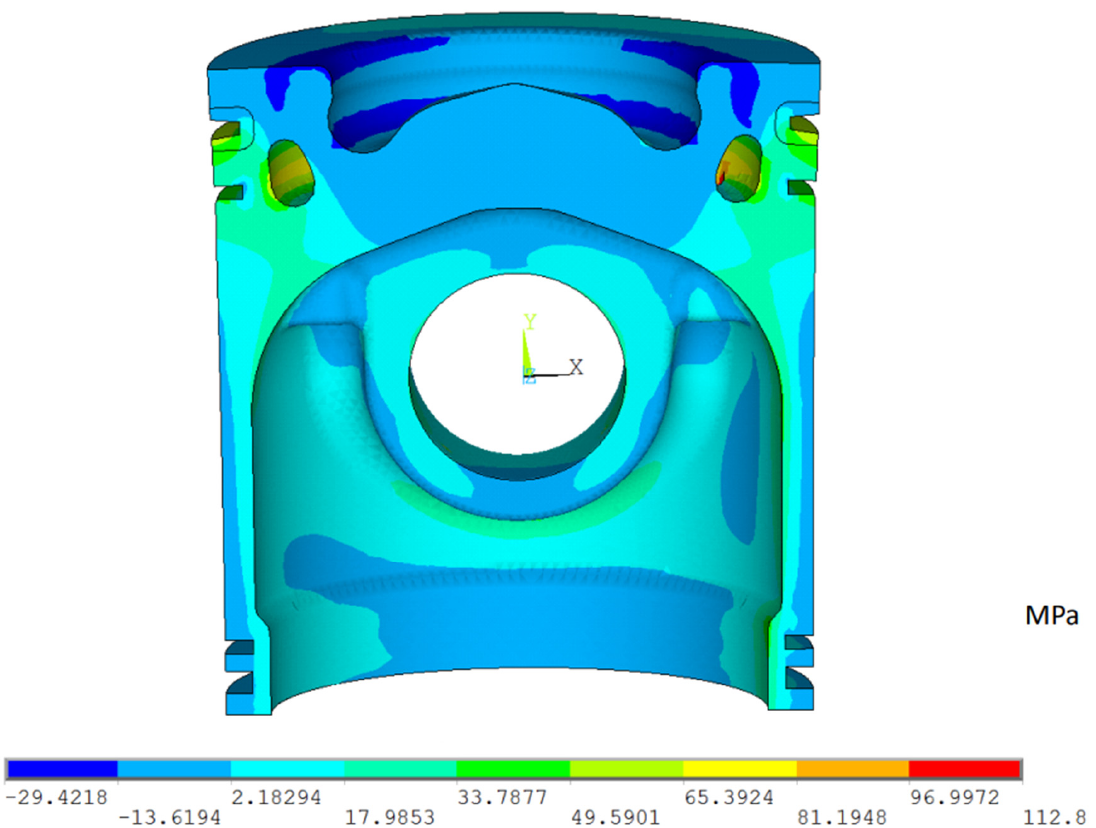
Figure 6. Piston stress analysis under thermal–mechanical coupling in Scheme 2.